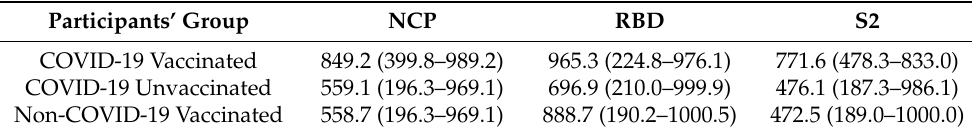
Table 3. The level of NCP, RBD, and S2 antibodies (U/mL) in the studied groups 1 . Participants’ Group